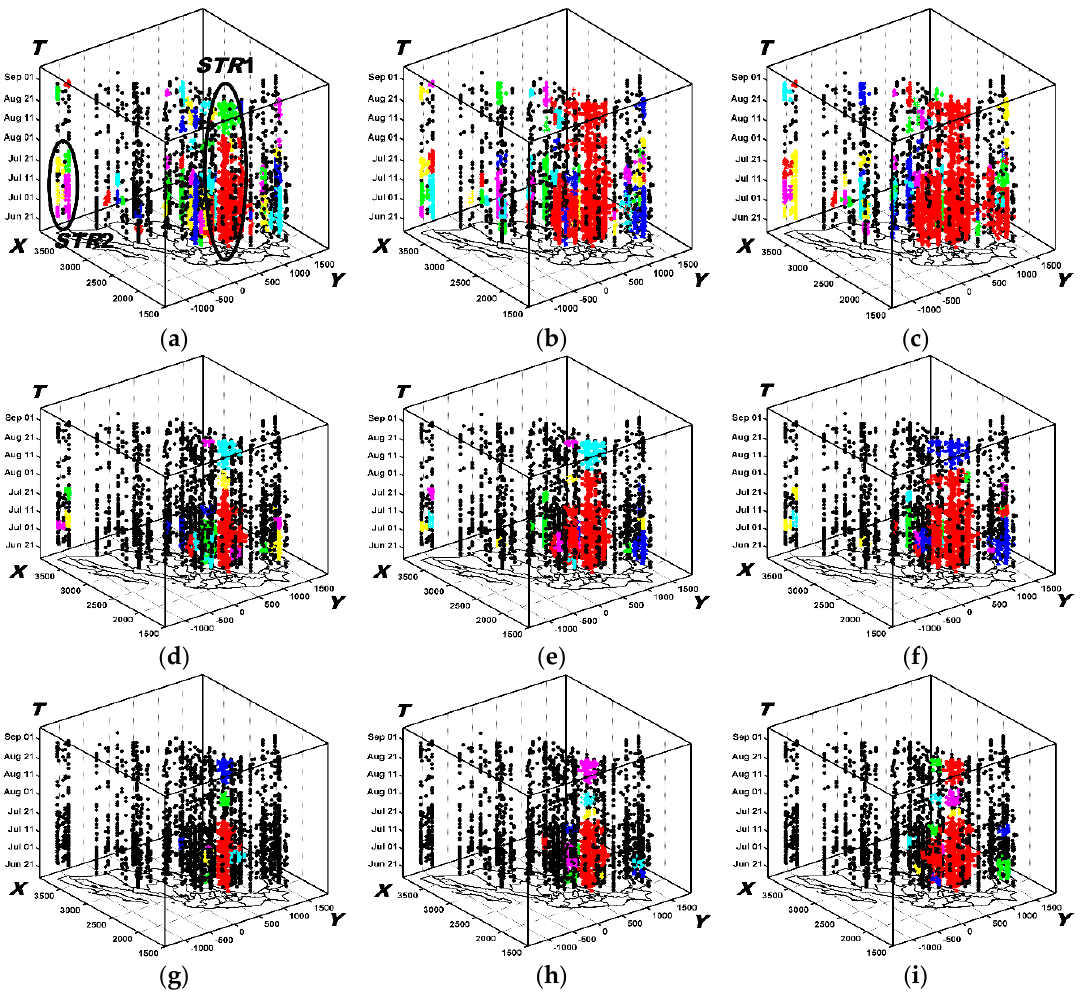
Figure 12. The spatio-temporal clusters discovered by ST-DBSCAN. ( a ) Eps = 70, MinPts = 5, Δ T = 2; ( b ) Eps = 85, MinPts = 5, Δ T = 2; ( c ) Eps = 100, MinPts = 5, Δ T = 2; ( d ) Eps = 70, MinPts = 10, Δ T = 2; ( e ) Eps = 85, MinPts = 10, Δ T = 2; ( f ) Eps = 100, MinPts = 10, Δ T = 2; ( g ) Eps = 70, MinPts = 15, Δ T = 2; ( h ) Eps = 85, MinPts = 15, Δ T = 2; ( i ) Eps = 100, MinPts = 15, Δ T = 2.